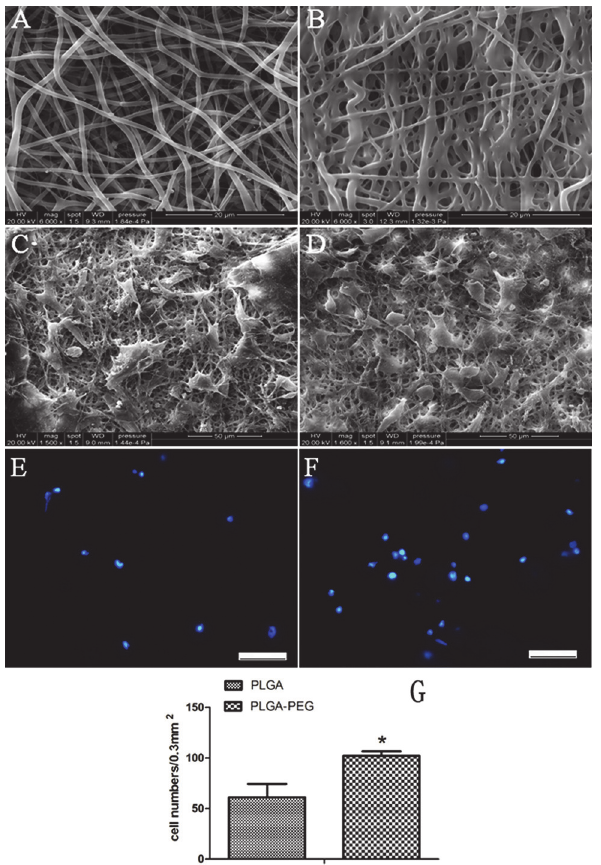
better on PLGA-PEG electrospun nanofibers (D) compared to PLGA nanofibers (C). Hoechst staining shows normal morphology and quality of nuclei, no obvious cellular apoptosis or necrosis in PLGA-PEG groups (F). Besides, both of SEM and nuclei staining showed the cell population grew on PLGA-PEG scaffold was larger than that of PLGA scaffold (P < 0.05 Student t-test, n = 5) (G). Scale bars = 50 μ m (E,